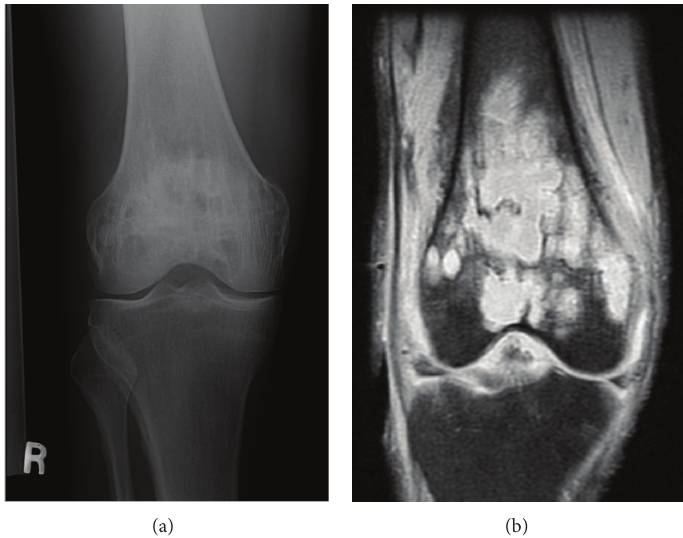
Figure 1: (a) and (b) showing X-ray and MRI, respectively.